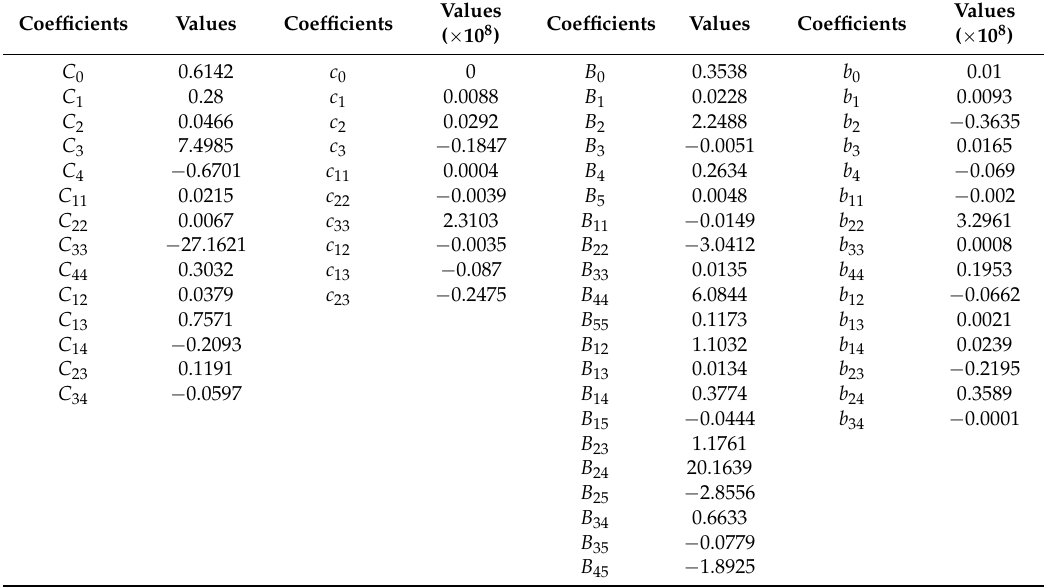
Table 6. Response surface coefficients for W-ASP-W and W-ASP-P-W.